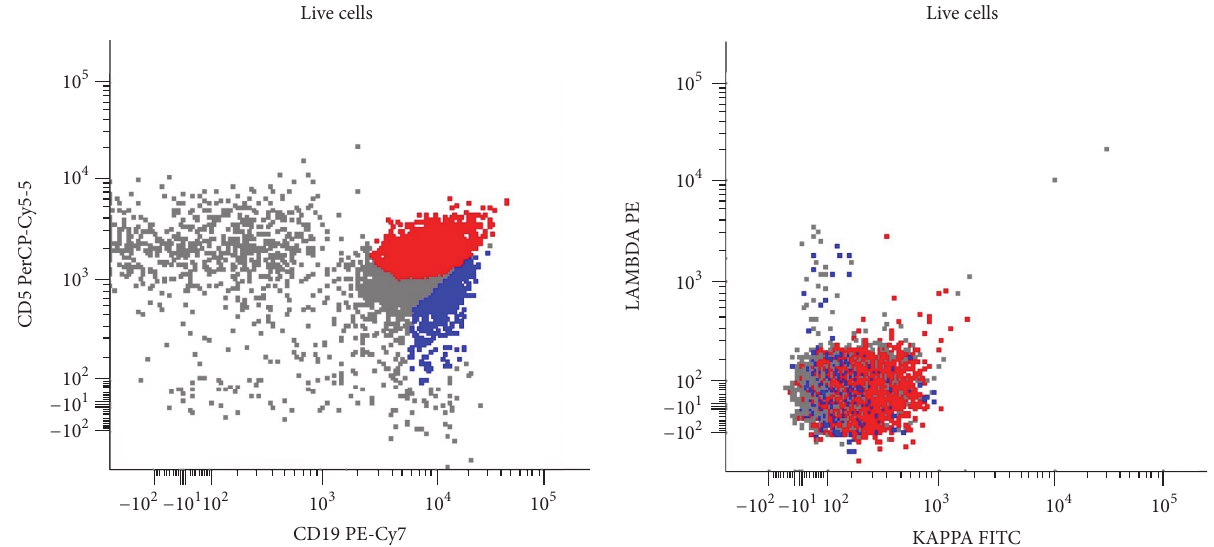
Figure 4: Flow cytometry of core needle biopsy: surface kappa clonal and CD19/CD20+ B cell population along with coexpression of CD5 and CD23 (tumor = red population; background polyclonal B cells =